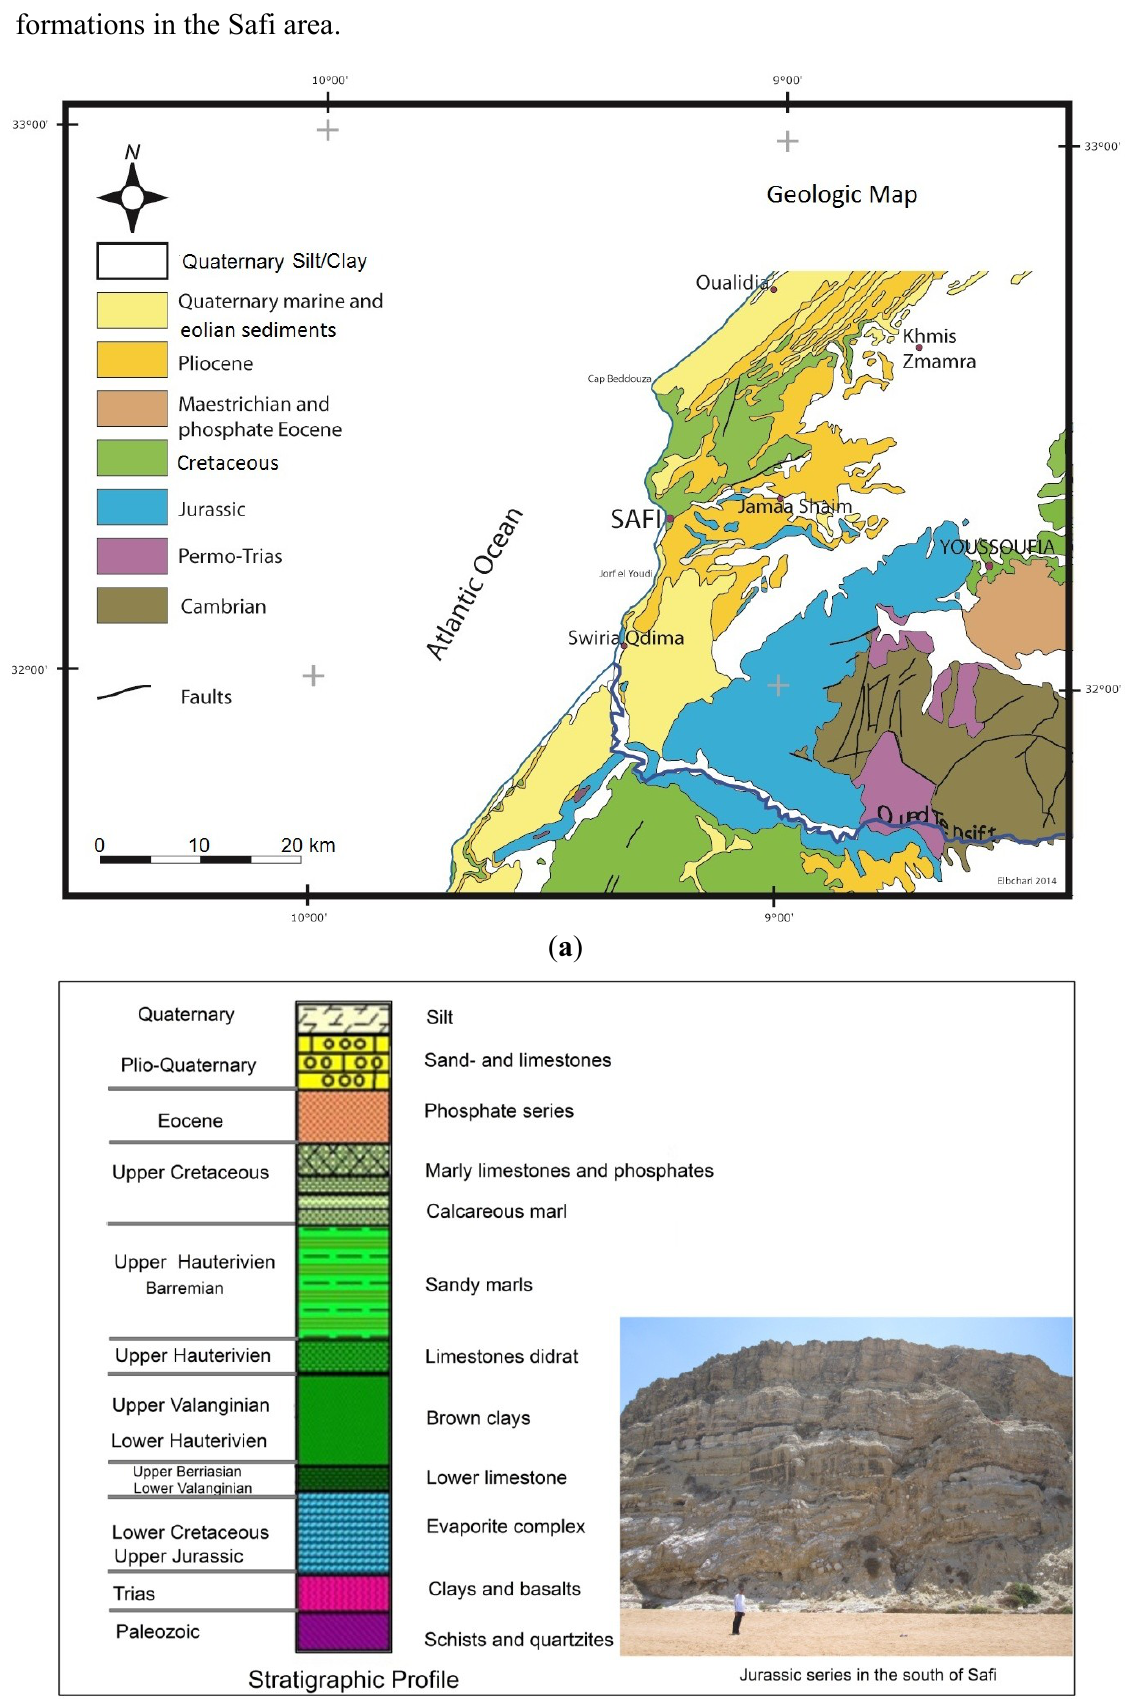
Figure 8. ( a ) Geologic overview of the study area and ( b ) stratigraphic sequence of geological formations in the Safi